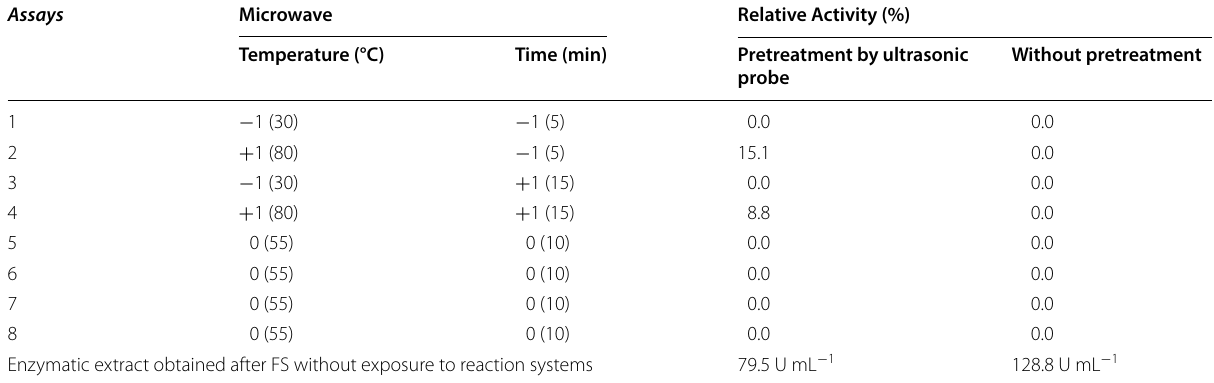
Table 5 Experimental planning matrix (real and coded values) and relative activity results (%) for the conditions evaluated in the reaction system by microwave irradiation with enzymatic extracts produced from swine hair pretreated and non-pretreated with an ultrasonic